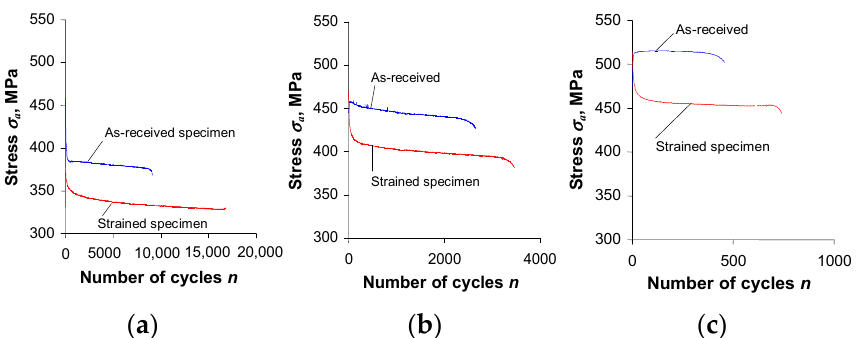
Figure 7. Influence of pre-strain on stress amplitude σ a : ( a ) ε ac = 0.25%; ( b ) ε ac = 0.5%; ( c ) ε ac = 1.0%.